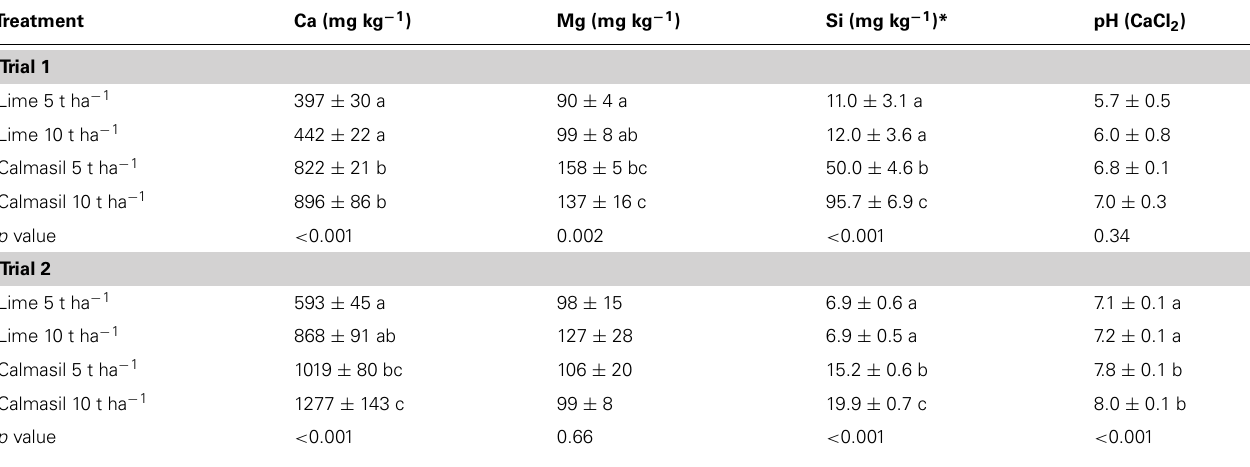
Table 1 | Soil analysis forTrials 1 and 2 at 5.5 months in response to lime and Calmasil treatments. Treatment